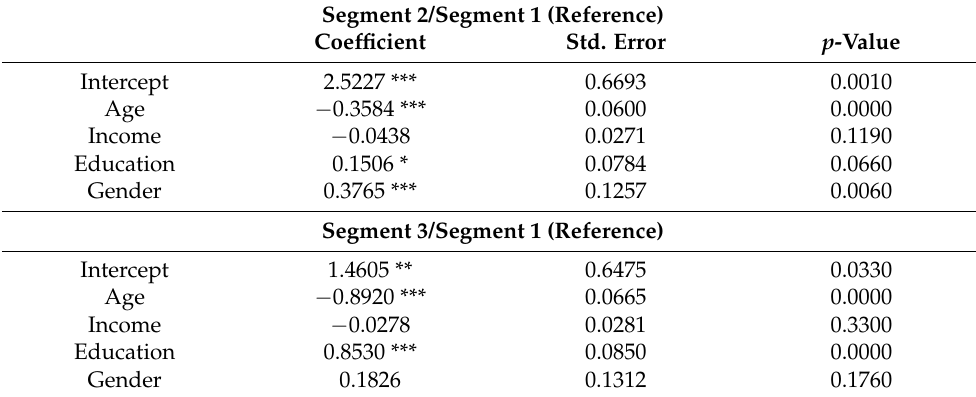
Table 8. Multinomial logit analysis on latent class